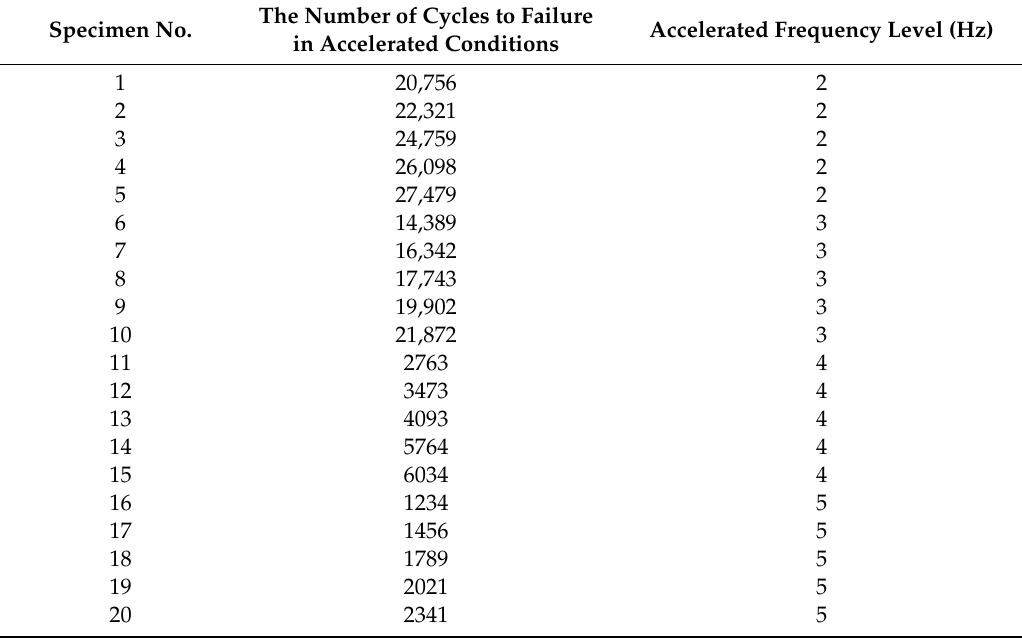
Table 3. Accelerated fatigue life testing results of the GFRP-foam specimens. Specimen No.